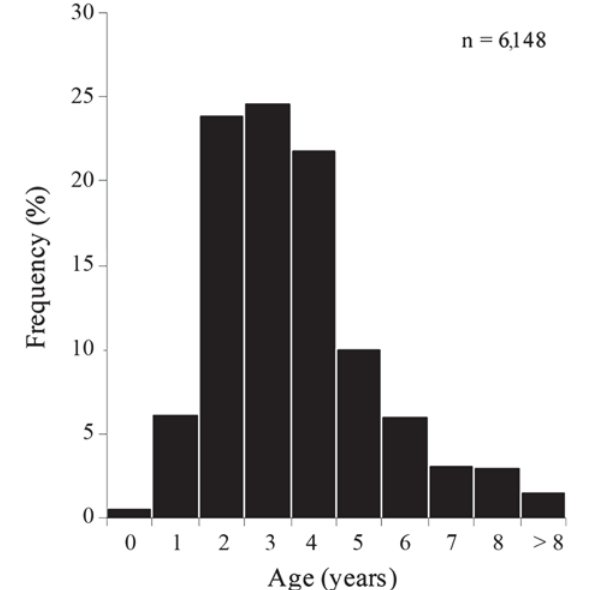
Fig. 10. Age composition for the Spanish mackerel ( Scomberomorus brasiliensis ) collected off northeastern